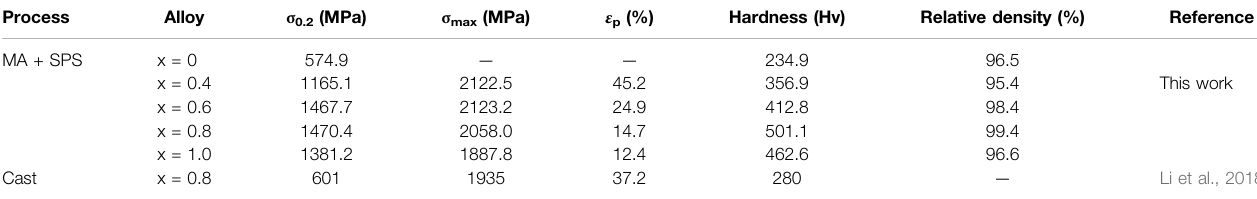
TABLE 7 | Mechanical properties of sintered FeCoNi(CuAl) x alloys and casting FeCoNi(CuAl) 0.8 HEA. Process